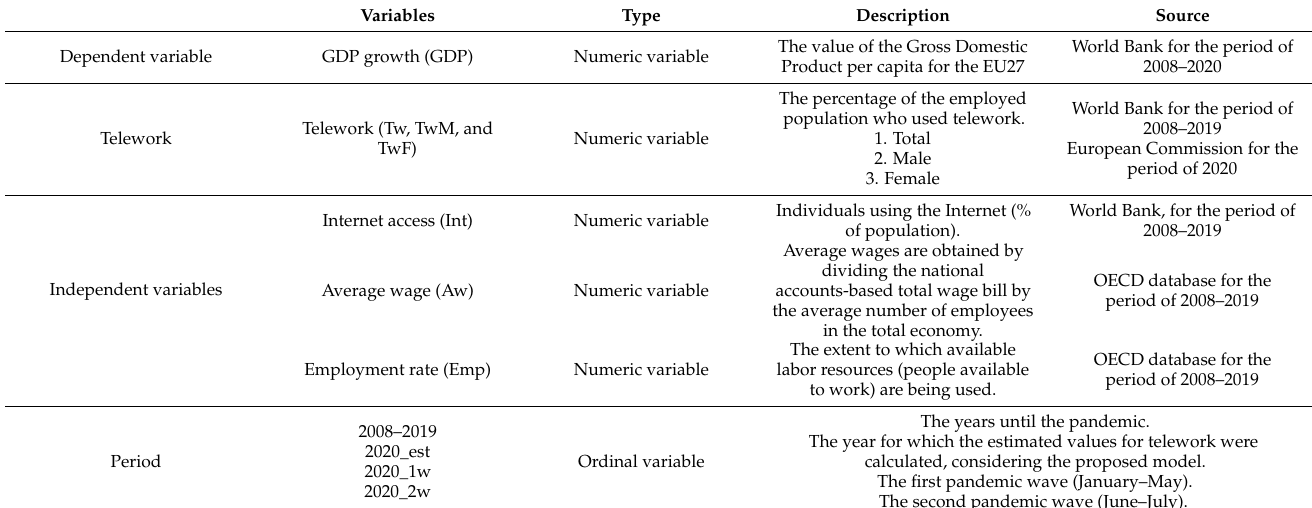
Table 1. Summary description of variable